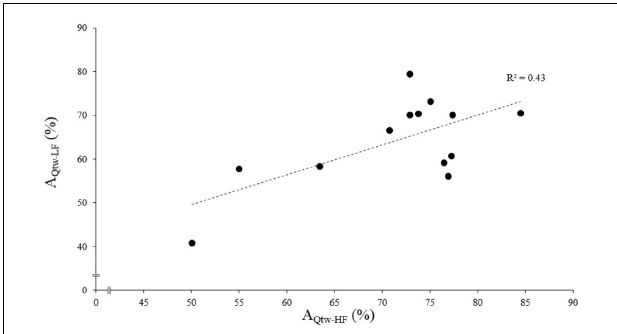
FIGURE 4 | Evoked torque asymptote correlation for high force (HF) and low force (LF) condition. Each dot represent an individual. The evoked torque asymptote for HF (A Qtw − HF ) and LF (A Qtw − LF ) are expressed as a percentage of the maximal value obtained during the pre-fatigue neuromuscular testing. The correlation was statistically significant, p <